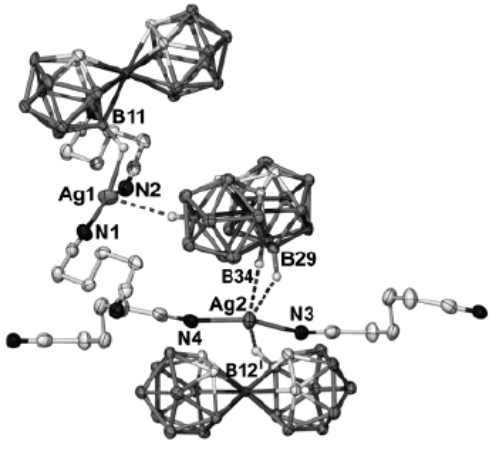
Figure 105. Fragment of X-ray structure of {((NC(CH 2 ) 4 CN)Ag)[3,3’-Co(1,2-C 2 B 9 H 11 ) 2 ]} n . Reprinted with permission from reference [105]. Copyright © (2004) American Chemical Society.